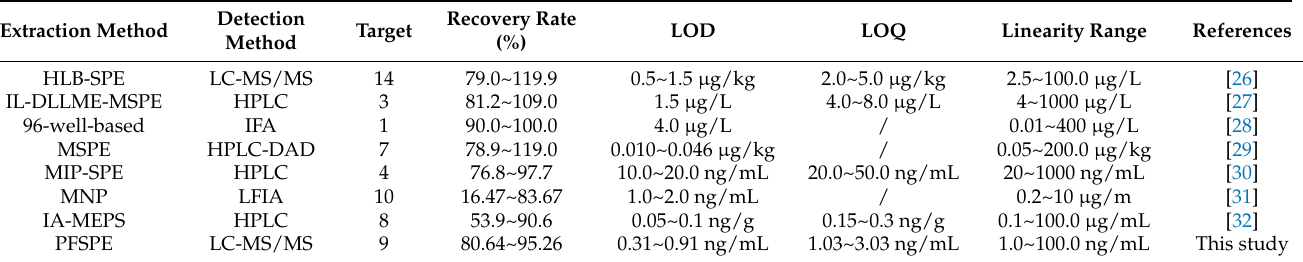
Table 5. Comparison of the selected analytical parameters using the developed method and the reported analytical methods.